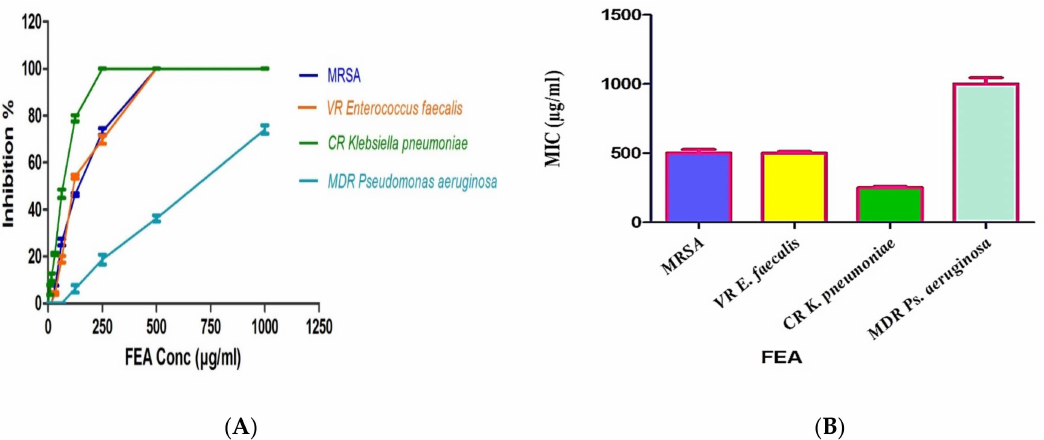
Figure 2. Inhibitory % and MIC values of FEA against different microbial resistance strains. ( A ) % of FEA extract inhibition against MDR bacteria. ( B ) MIC values of the FEA extract. All determinations were carried out in triplicate, and values are expressed as means ± SD.